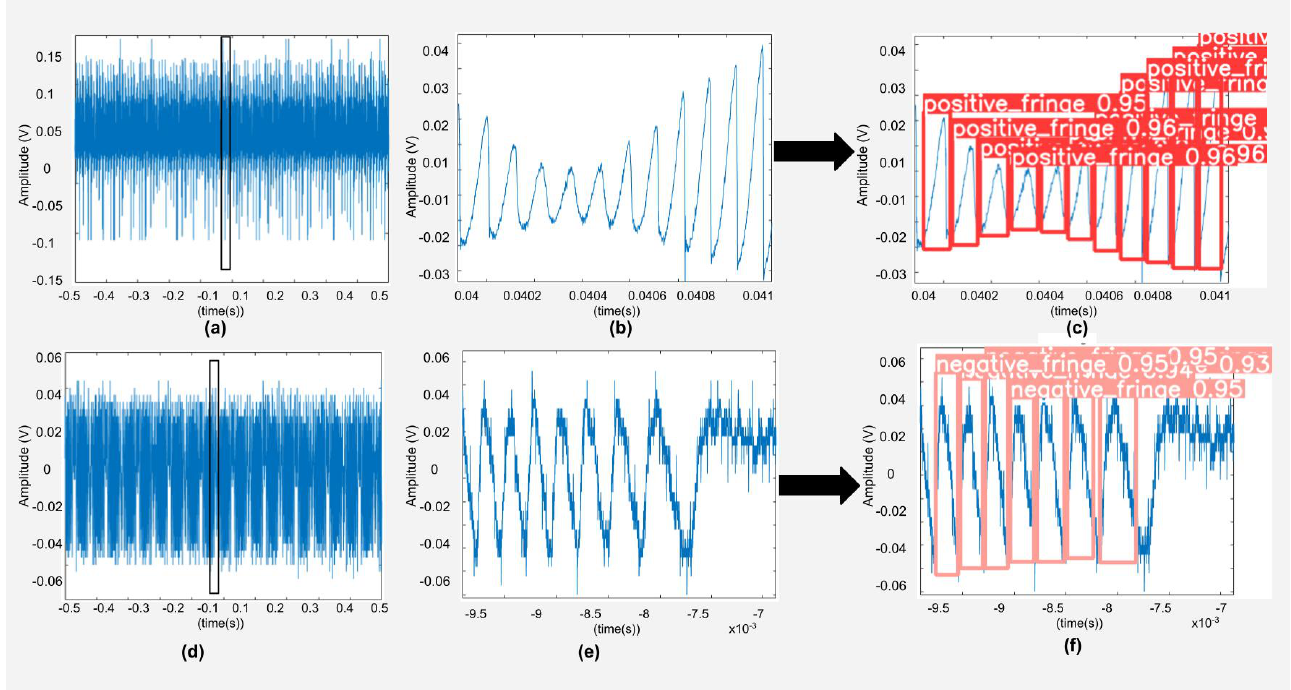
Figure 1. ( a ) An experimental speckle affected SMI signal from laser diode HL7851 emitting at a wavelength of 785 nm, ( b ) an enlarged view of its segment showing amplitude modulated SMI fringes, and ( c ) correct fringe detection and classification of these fringes. ( d ) A noisy experimental SMI signal emitting at a wavelength of 785 nm, ( e ) an enlarged view of its segment, and ( f ) correct fringe detection and classification using the proposed deep